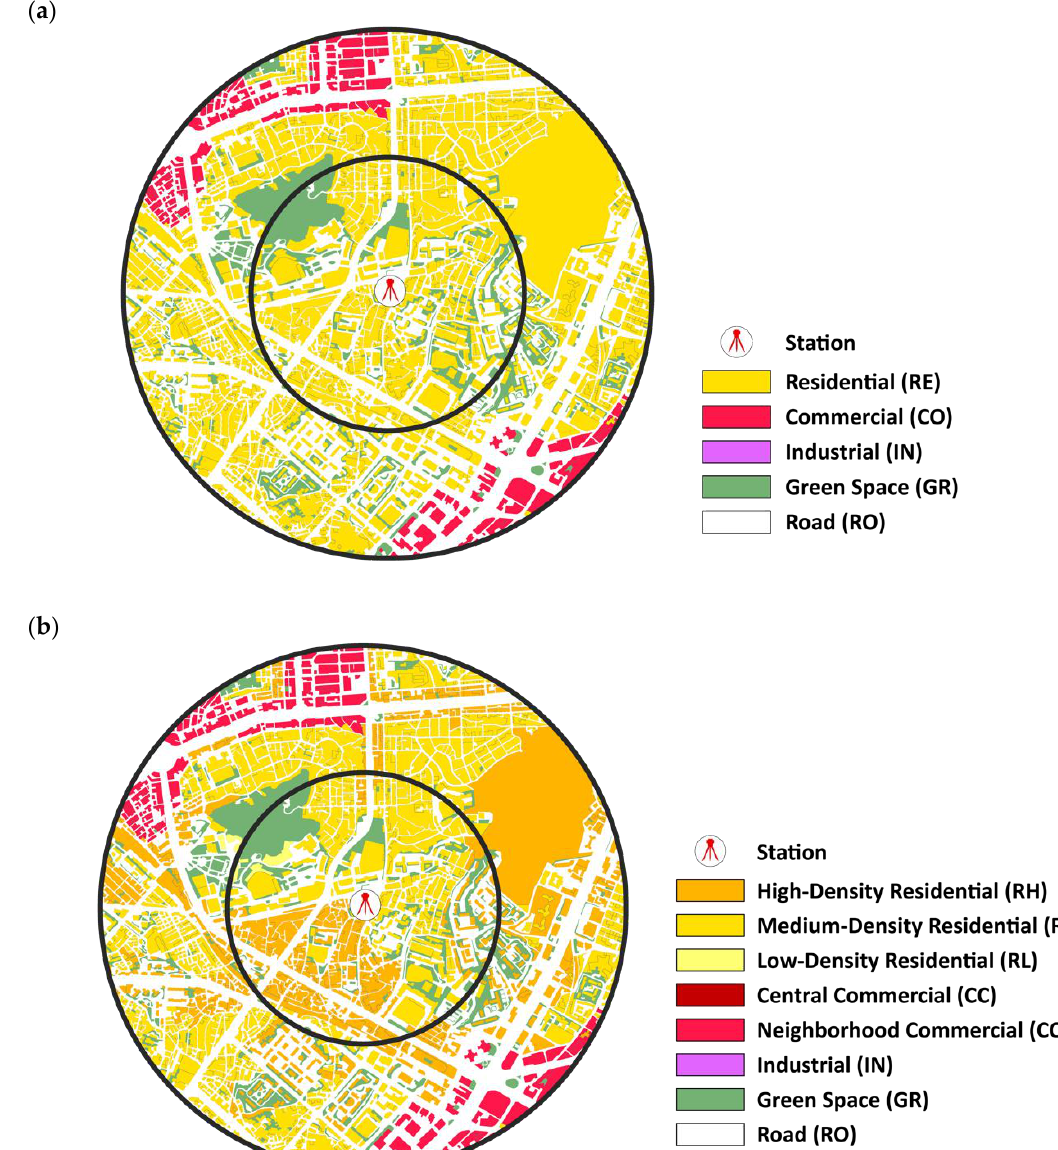
Figure 4. Surrounding land use conditions for the Mapo district monitoring station based on ( a ) the first classification with five land use types and ( b ) the second classification with eight types. The station is located at the center of each circle. The inner and the outer circles indicate 0.5 km and one kilometer from the station, respectively.